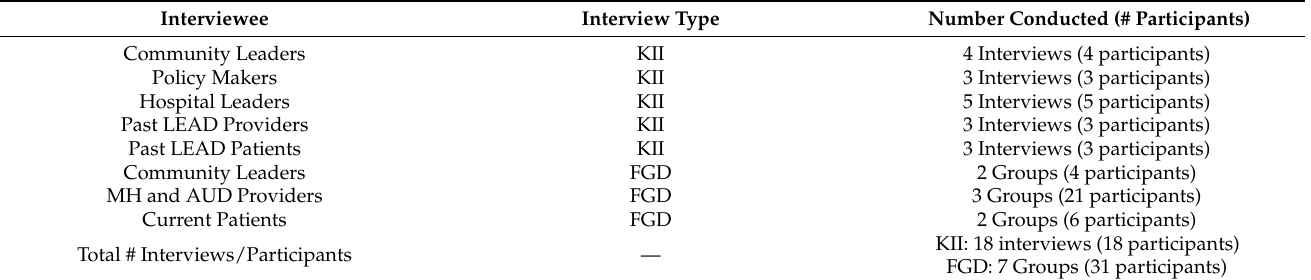
Table 1. Participant Interview